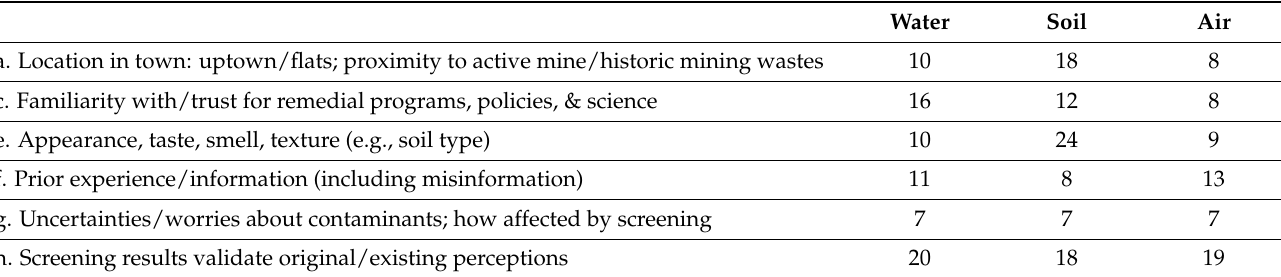
Table 2. Categories characterizing aggregated (pre & post) participant qualitative responses. Numbers represent total aggregated comments—positive and negative—associated with each category.